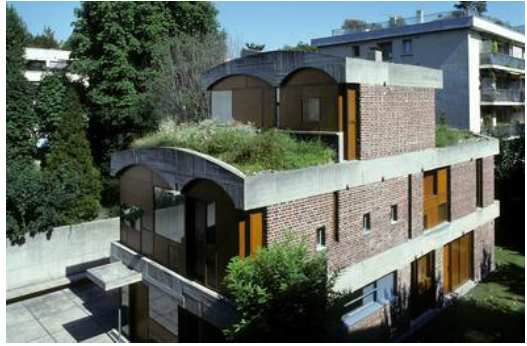
Figure 10. Maison Jaoule-exterior.